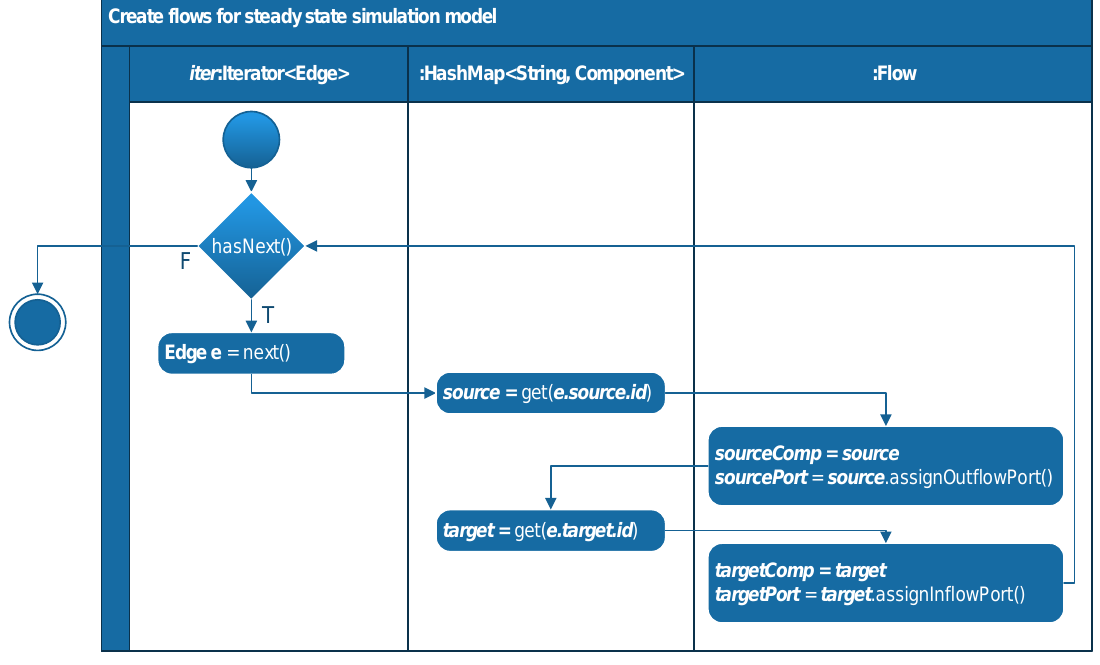
Figure 7. UML activity diagram representation of an algorithm that creates the flows and connects them to the correct ports according to the mapping rules in Table 1.